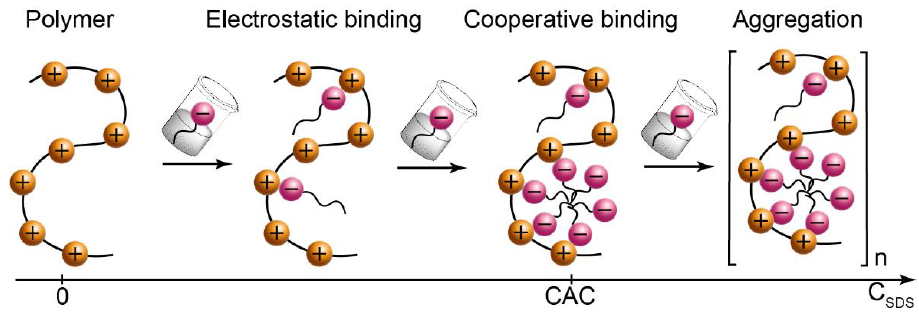
Figure 1. Binding surfactant ions by polyelectrolyte macrochains expected for the PDADMAC-SDS solutions at various concentrations of added surfactant. CAC is the critical association concentra- tion.